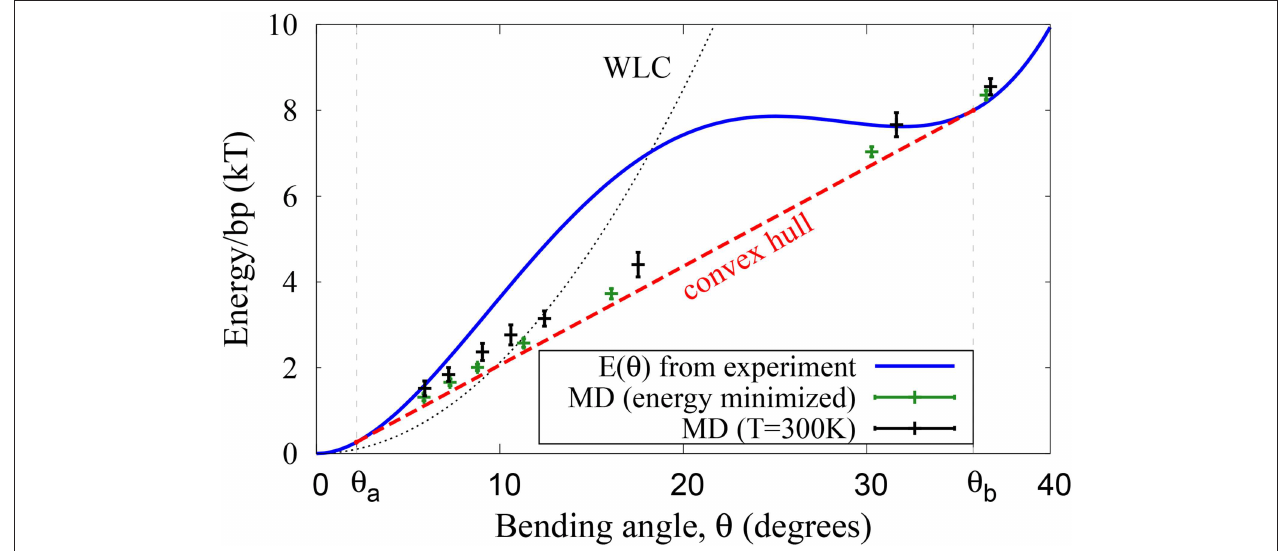
FIGURE 4 | DNA effective bending energy E ( θ ) (per bp) extracted from the probability distribution [42] of DNA bends that naturally occur in protein-DNA complexes (blue line), and the average energy of unrestrained DNA closed loops simulated via coarse-grained MD with the same E ( θ ) (crosses). Green symbols: energy minimized (simulated annealing) loops. Black symbols: loops simulated at T=300K. In both cases, the average loop energy as a function of average bend angle ¯ θ = θ follows the convex hull of E ( θ ). The small deviation of the T = 300 K points from the convex hull are a result of ensemble average sampling and insignificant out-of-plane bending seen in the